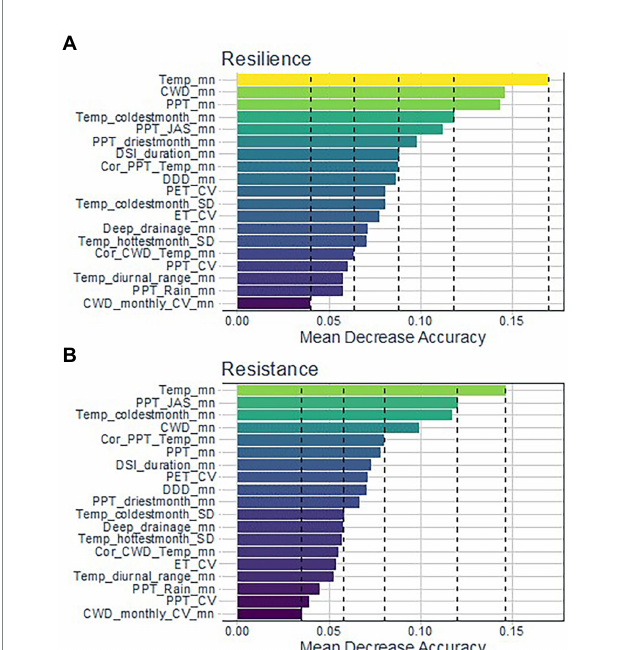
FIGURE 2 Climate and water availability variables ranked by permutation-based Mean Decrease in Accuracy (MDA) for the best random forest models of (A) resilience (overall model accuracy = 0.80, sensitivity = 0.78) and (B) resistance (accuracy = 0.75, sensitivity = 0.74) for the study area. Dashed lines indicate Jenks natural breaks dividing the set into five